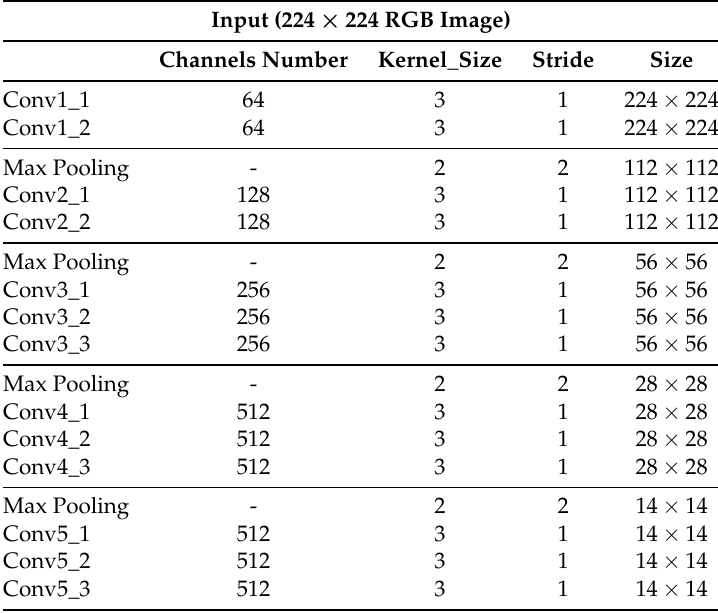
Table 1. The struct of